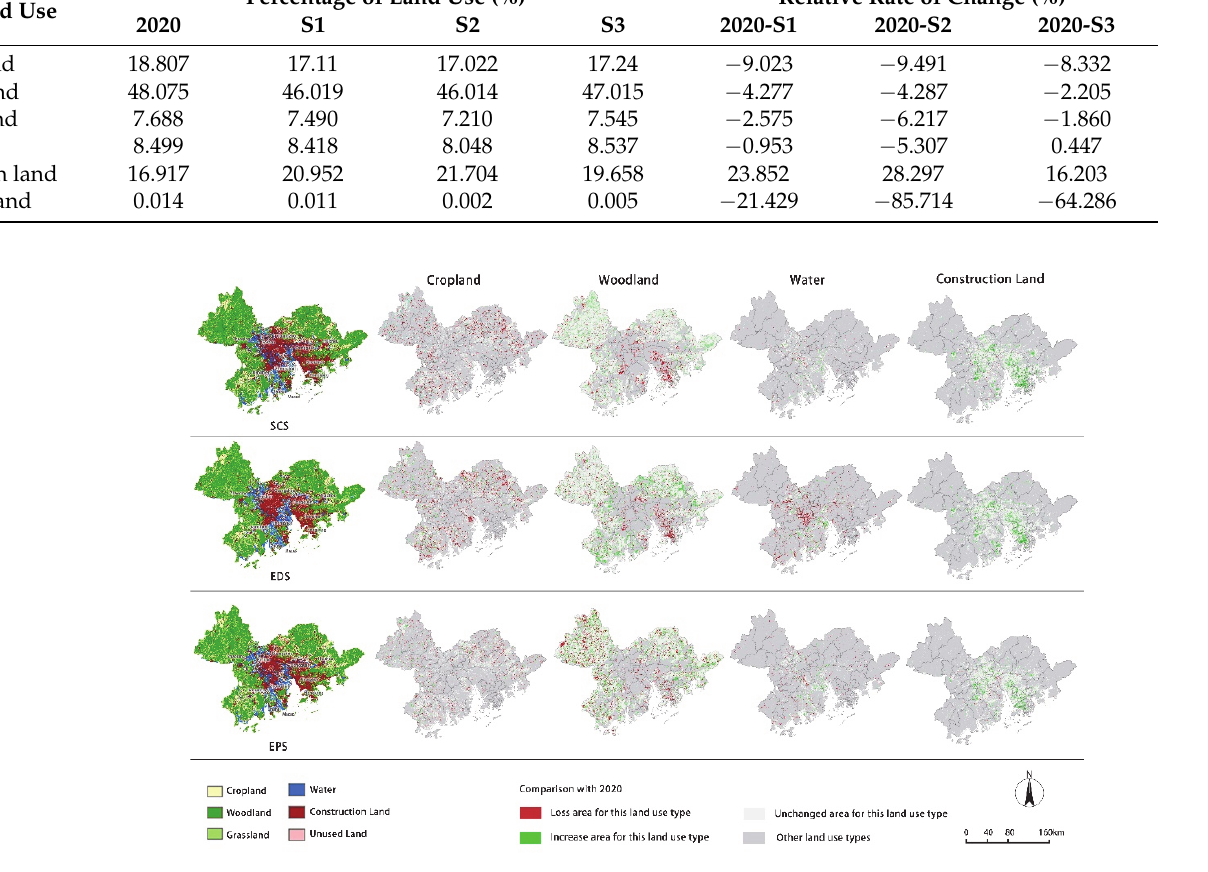
Figure 10. Forecast results of land expansion and changes in cropland, woodland, water area, and construction land in 2035 under scenarios S1, S2, and S3.